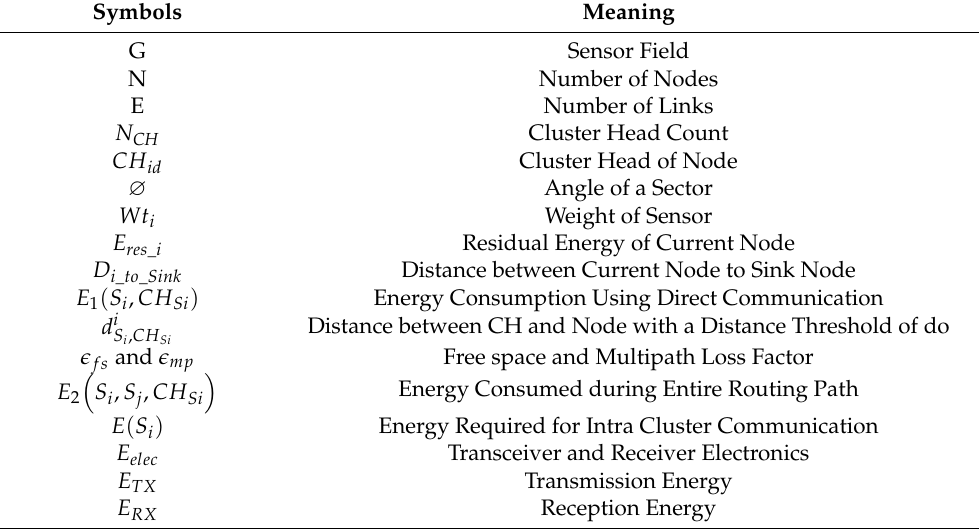
Table 1. Symbols and notations used in the proposed